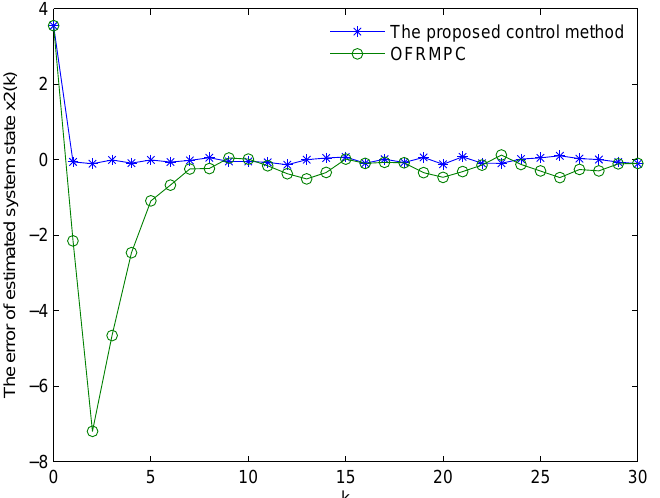
Figure 4. The estimated error of system state x2 for the proposed method and OFRMPC